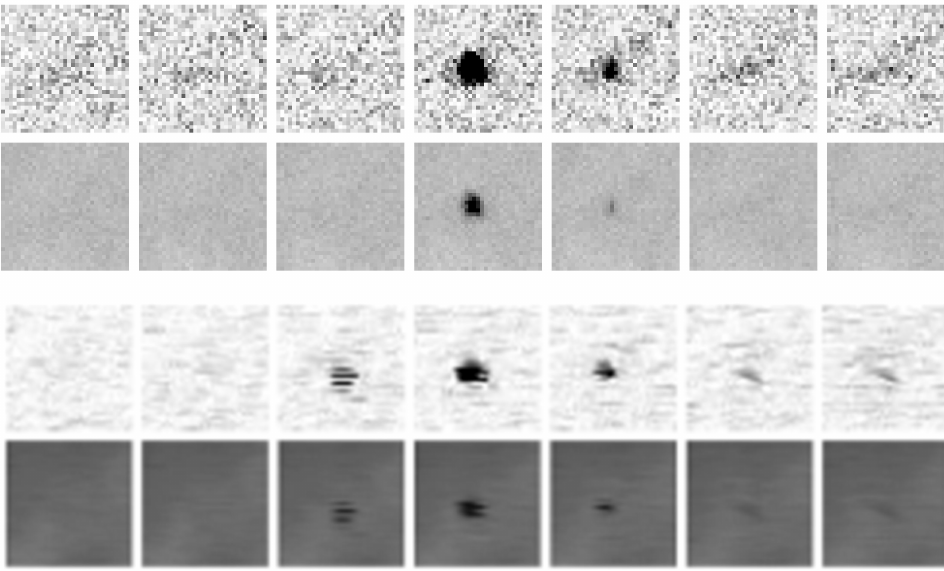
Figure 4. TIFF files of a seven-frame sequence generated by LunarScan for Flash 1, from the recordings at Macei ó at 4.46 FPS ( top ), and Araruna at 30 FPS ( bottom ), inverted